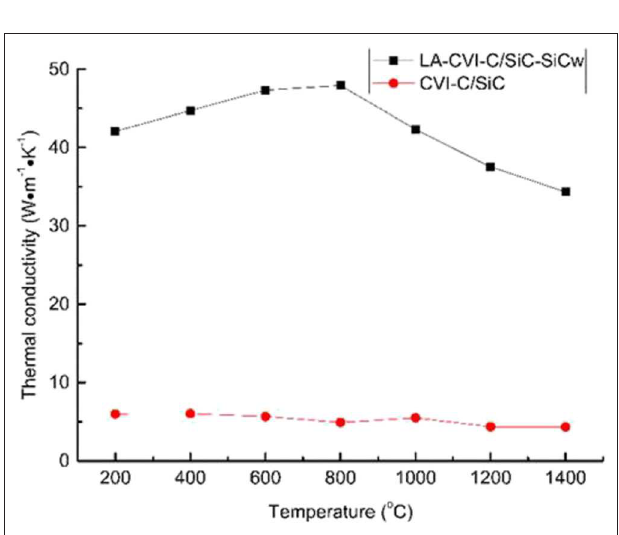
FIGURE 5 | Thermal conductivity of laser-assisted chemical vapor infiltration (LA-CVI)–continuous fiber-reinforced silicon carbide (SiC) ceramic matrix (C/SiC)–SiC whiskers (SiCw) and